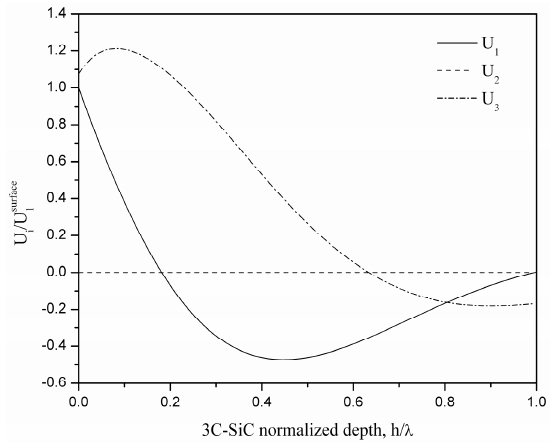
Figure 3. The particle displacement components of the Rayleigh-like wave propagating along the x - axis in 3C-SiC(001).